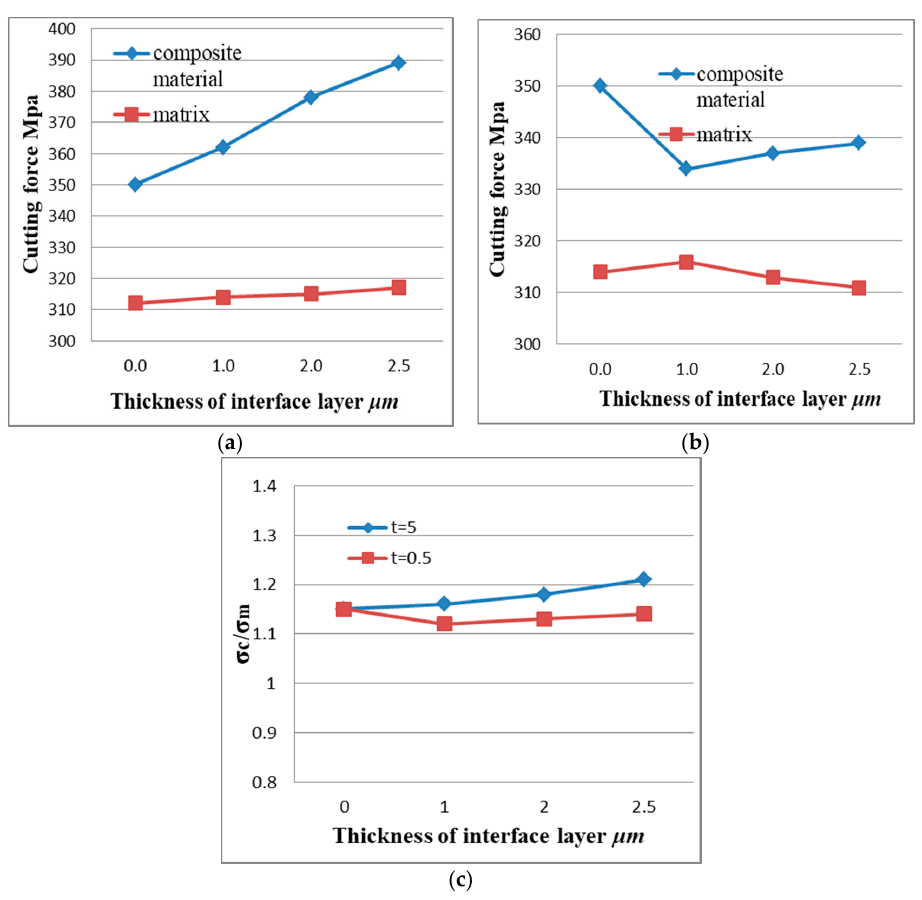
Figure 22. Effect of interface layer properties on composite stress: ( a ) Flexible interface ( t = 0.5), ( b ) rigid interface ( t = 5), and ( c ) proportional coefficient.